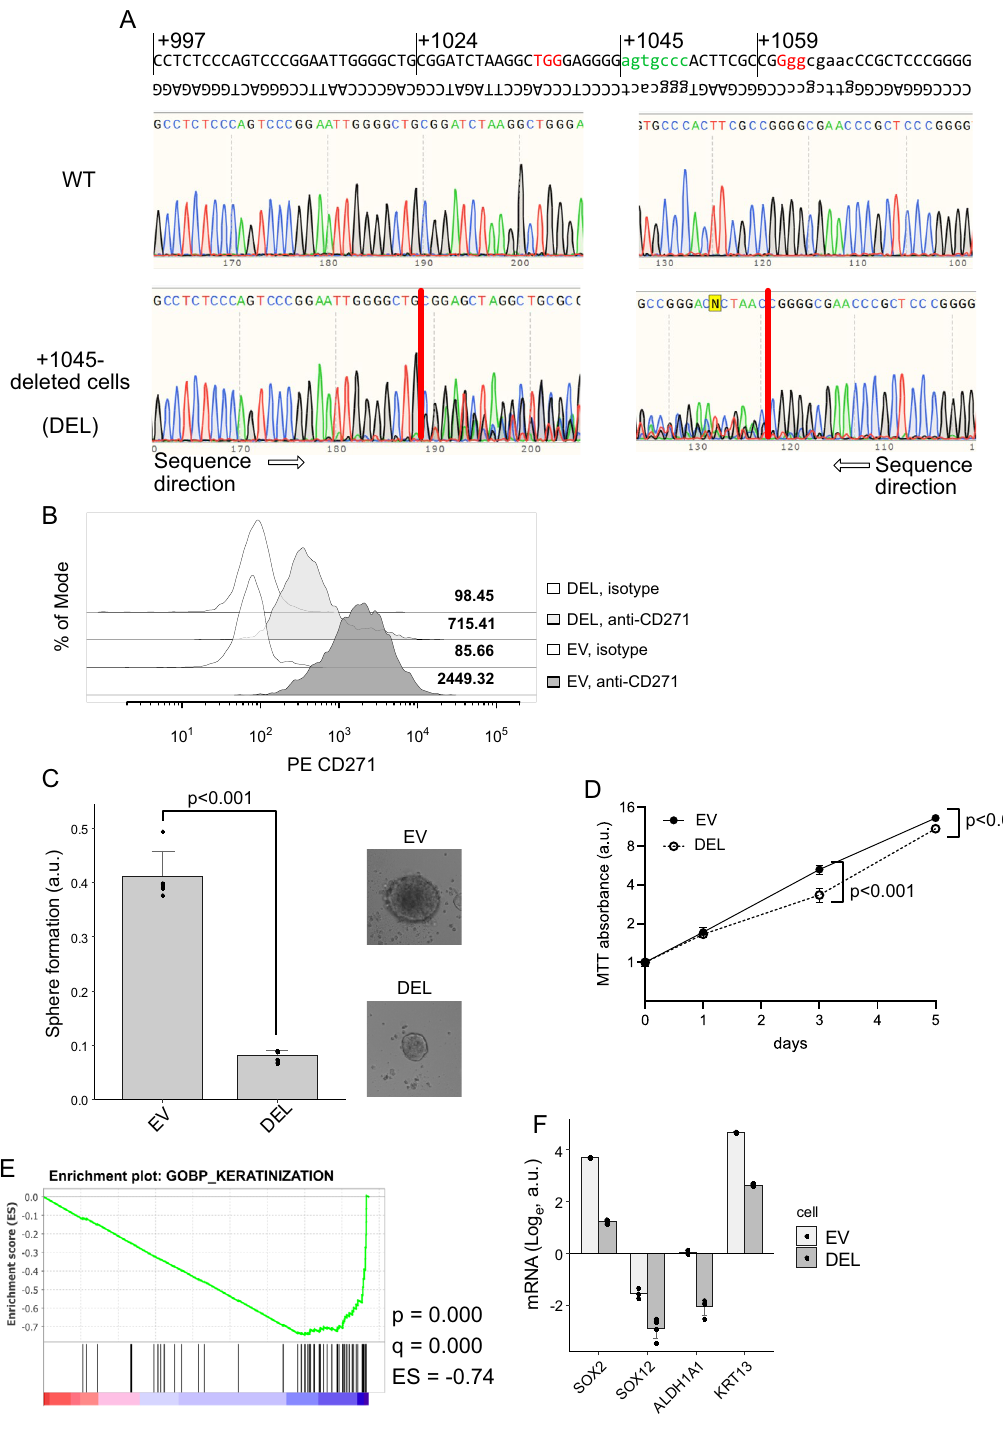
Figure 5. Deletion of the RELA-binding site reduces sphere-formation activity in HPCM2 cells. ( A ) Sequence chromatograms of cells harboring deletion of site + 1045 (DEL). Red characters indicate protospacer adjacent motif sequences, and green characters indicate the + 1045 RELA-binding site. ( B ) CD271 expression according to flow cytometry. The numbers in the histogram indicate the mean fluorescence intensity of phycoerythrin- conjugated anti-CD271. ( C ) Sphere-formation activity of RELA binding site-knock out HPCM2 cells according to MTT assay. DEL, cells harboring deletion of the RELA-binding site (+ 1045); EV, empty vector (control cells). Right panels show the representative images of the spheroid cells. ( D ) Cell proliferation assay. EV and DEL HPCM2 cells were seeded (1000 cells/well) and cultured and cell numbers were determined by MTT assay. ( E ) GSEA analysis. The exression microarray data of EV versus DEL were compared using GSEA software. A gene set of keratinization was downregulated in EV